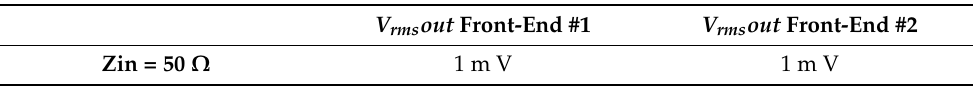
Figure 4. The block-scheme of the new design of the receiver board.